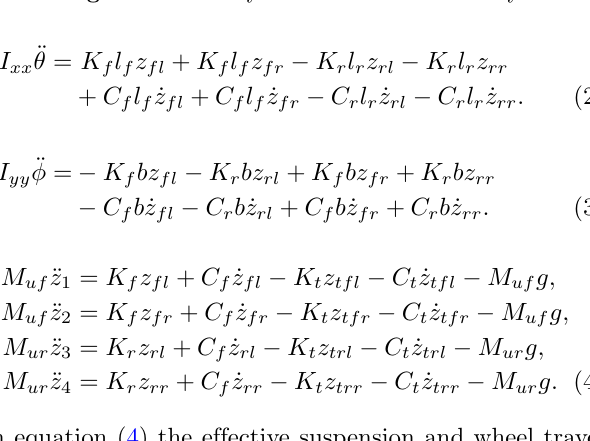
Fig. 3. Vertical dynamics of the vehicle body.